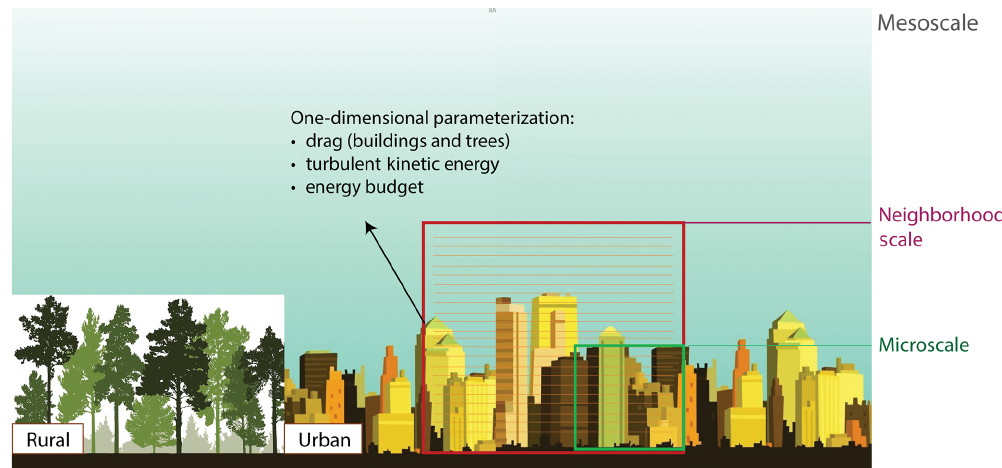
Figure 1. Schematic of urban canopy parameterization (UCP) in multi-layer column models at mesoscale.